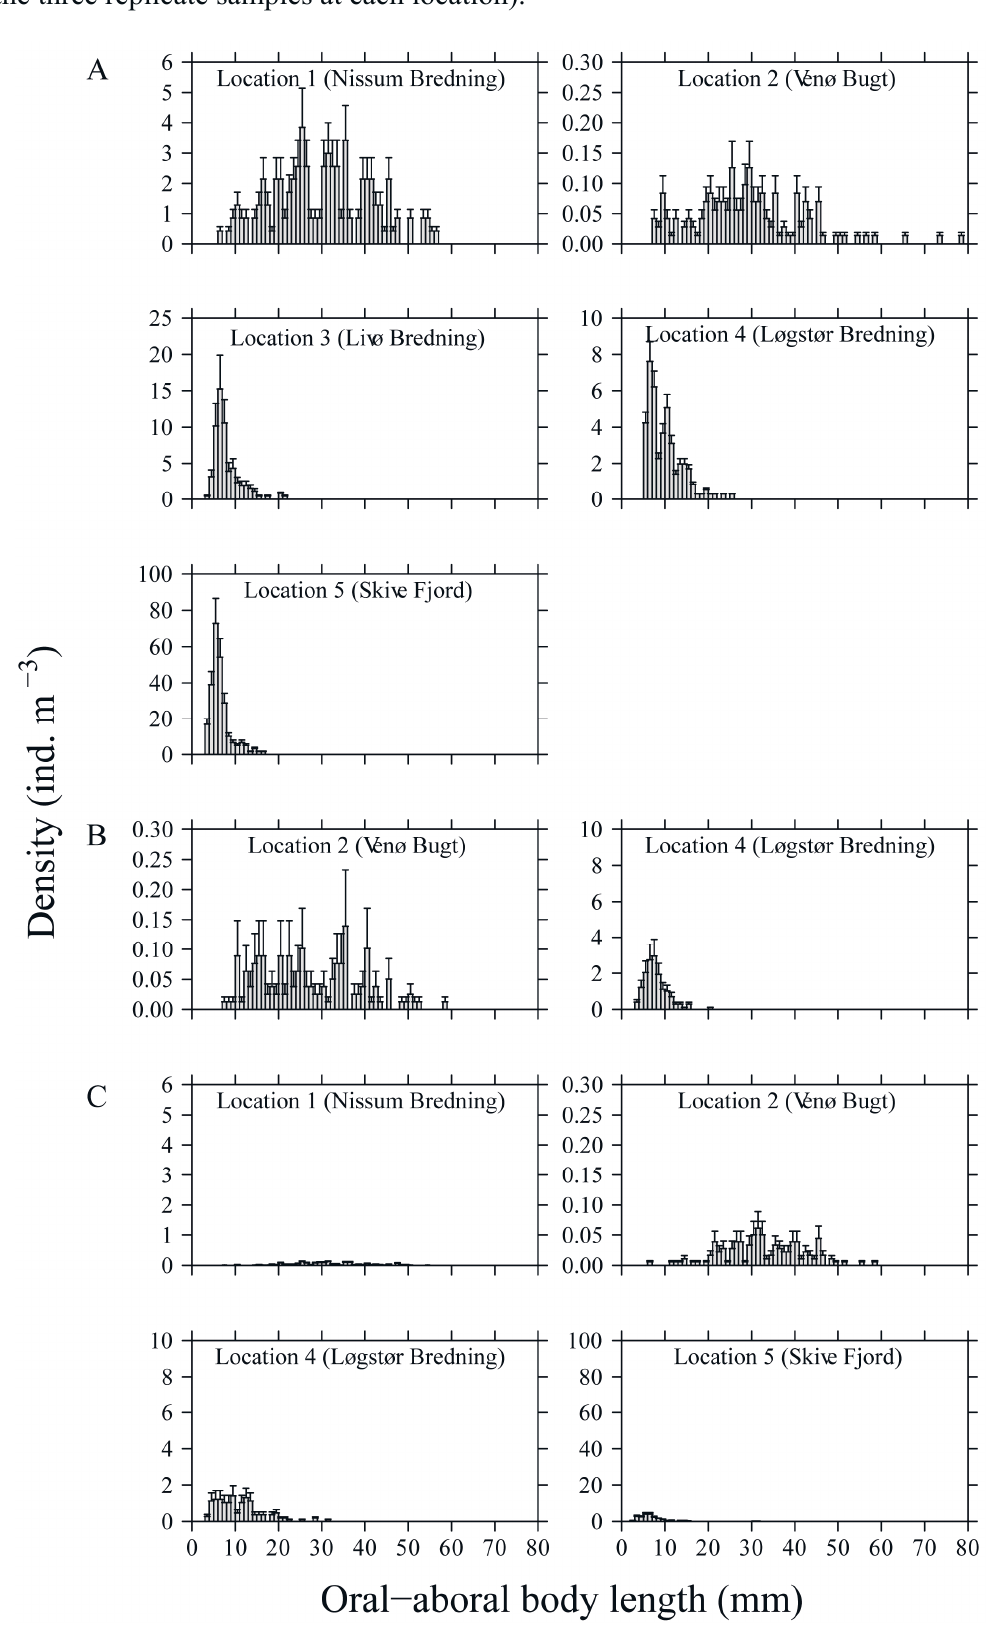
Figure 6. Mnemiopsis leidyi. Oral–aboral length distribution of ctenophores for the five investigated locations in Limfjorden on: ( A ) 23 September; ( B ) 23 October; and ( C ) 20 November 2013. Average densities for each mm size category are displayed (±SD for the three replicate samples at each